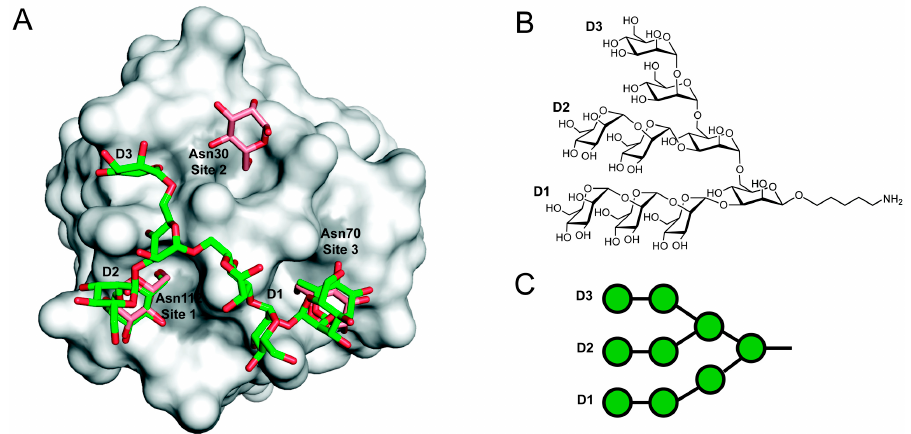
Figure 2. Model of a GRFT-Man9 complex. ( A ) Representation of the structure of monomeric GRFT (gray surface) bound to nonamannoside (green sticks), Protein Data Bank accession 3LL2. Aspartic acid residues from each of the three glycan-binding sites are highlighted in grey. The structures of a GRFT:synthetic nonamannoside complex and a 1:3 mGRFT:mannose complex have been superimposed to compare the mannose binding sites. Only the D1 and D2 terminal mannoses are bound to a single GRFT monomer. Figure was rendered using PyMol. ( B ) Chemical structure of nonamannoside showing the D1, D2 and D3 arms; ( C ) Symbol representation of nonamannoside.